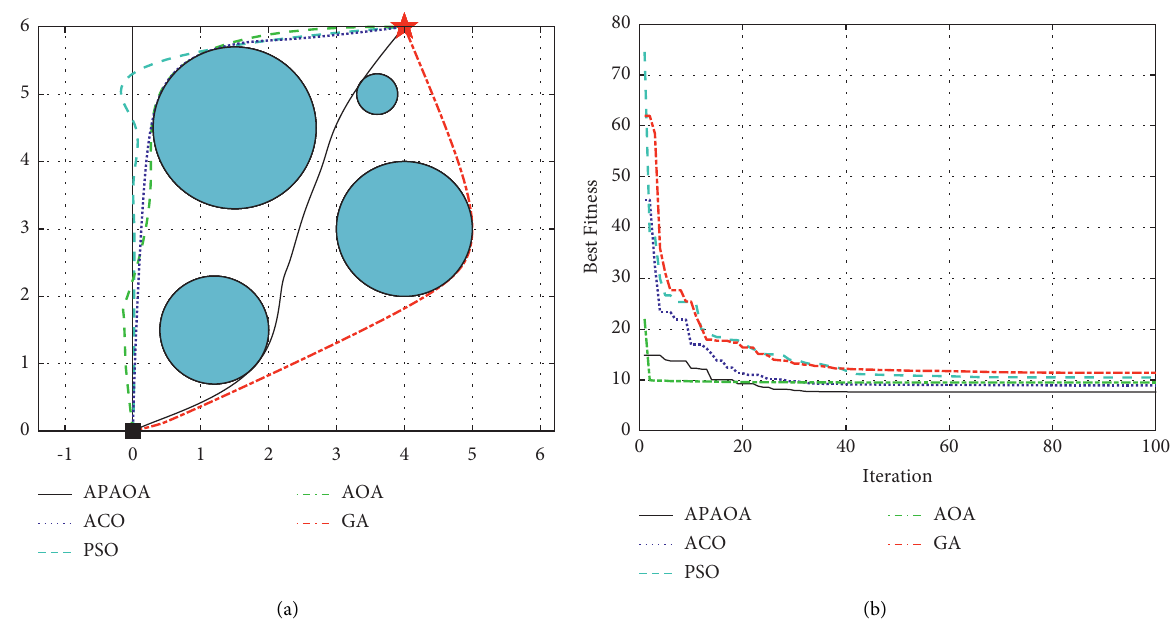
Figure 8: Path planning diagram (a) and convergence curve (b) of environment 1.